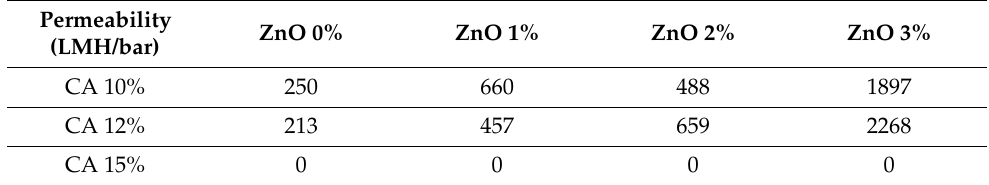
Table 4. Permeability values for the different prepared membranes.